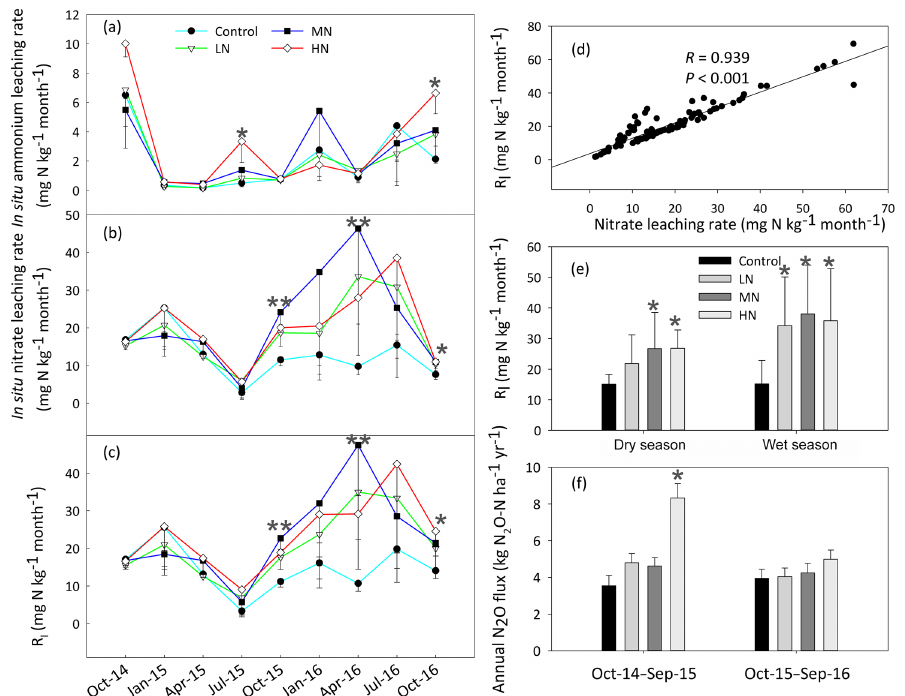
Figure 3. Dynamics of the in situ NH + -N (a) , NO − -N (b) and total inorganic N leaching rates ( R l ) (c) in the soils at different samplings. 4 3 (d) The correlation between the rates of nitrate leaching and inorganic nitrogen leaching ( R l ). (e) The variation in R l in the dry and wet season. (f) The rates of annual N 2 O emission with N addition. Bars represent standard errors of the mean ( n = 3). Significance levels are indicated by ∗ P < 0 . 05, ∗∗ P < 0 .